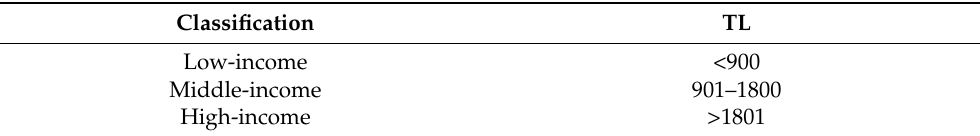
Table 2. Cut-offs for low-, middle-, high-income classification from quintiles (values pertain to monthly